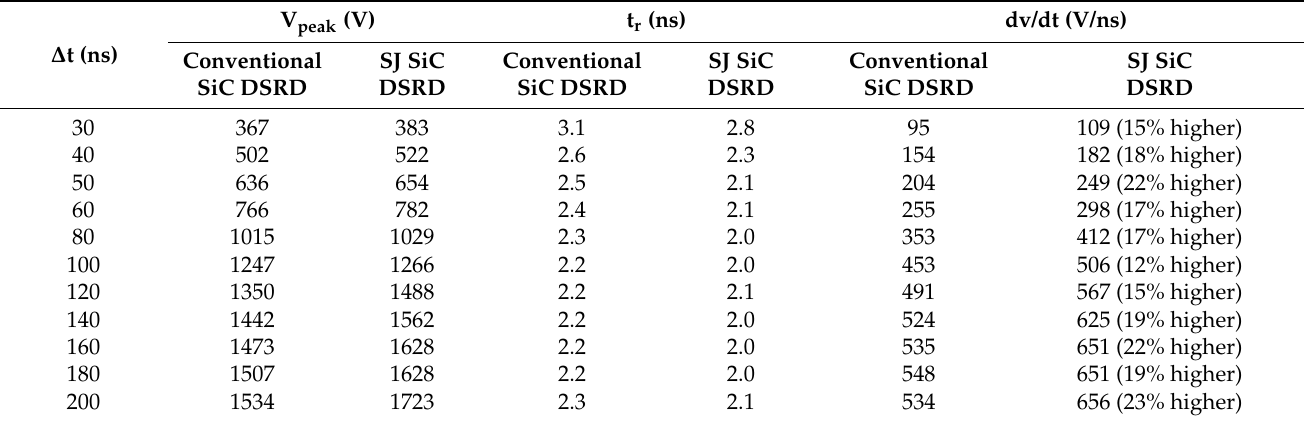
Table 4. Output voltage comparison of conventional SiC DSRD and SJ SiC DSRD when ∆ t is 30 ns, 40 ns, 50 ns, 60 ns, 80